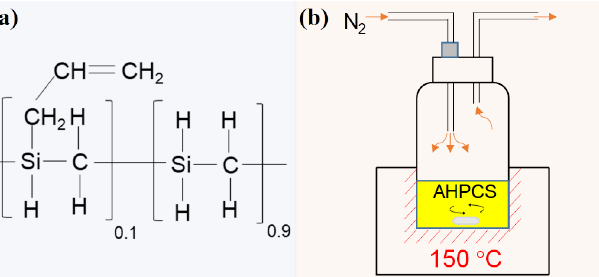
Figure 11. ( a ) Main structure of AHPCS; ( b ) schematic illustration of the thermal curing for pre- cross-linking of AHPCS. Reprinted from [73] with permission from Elsevier.